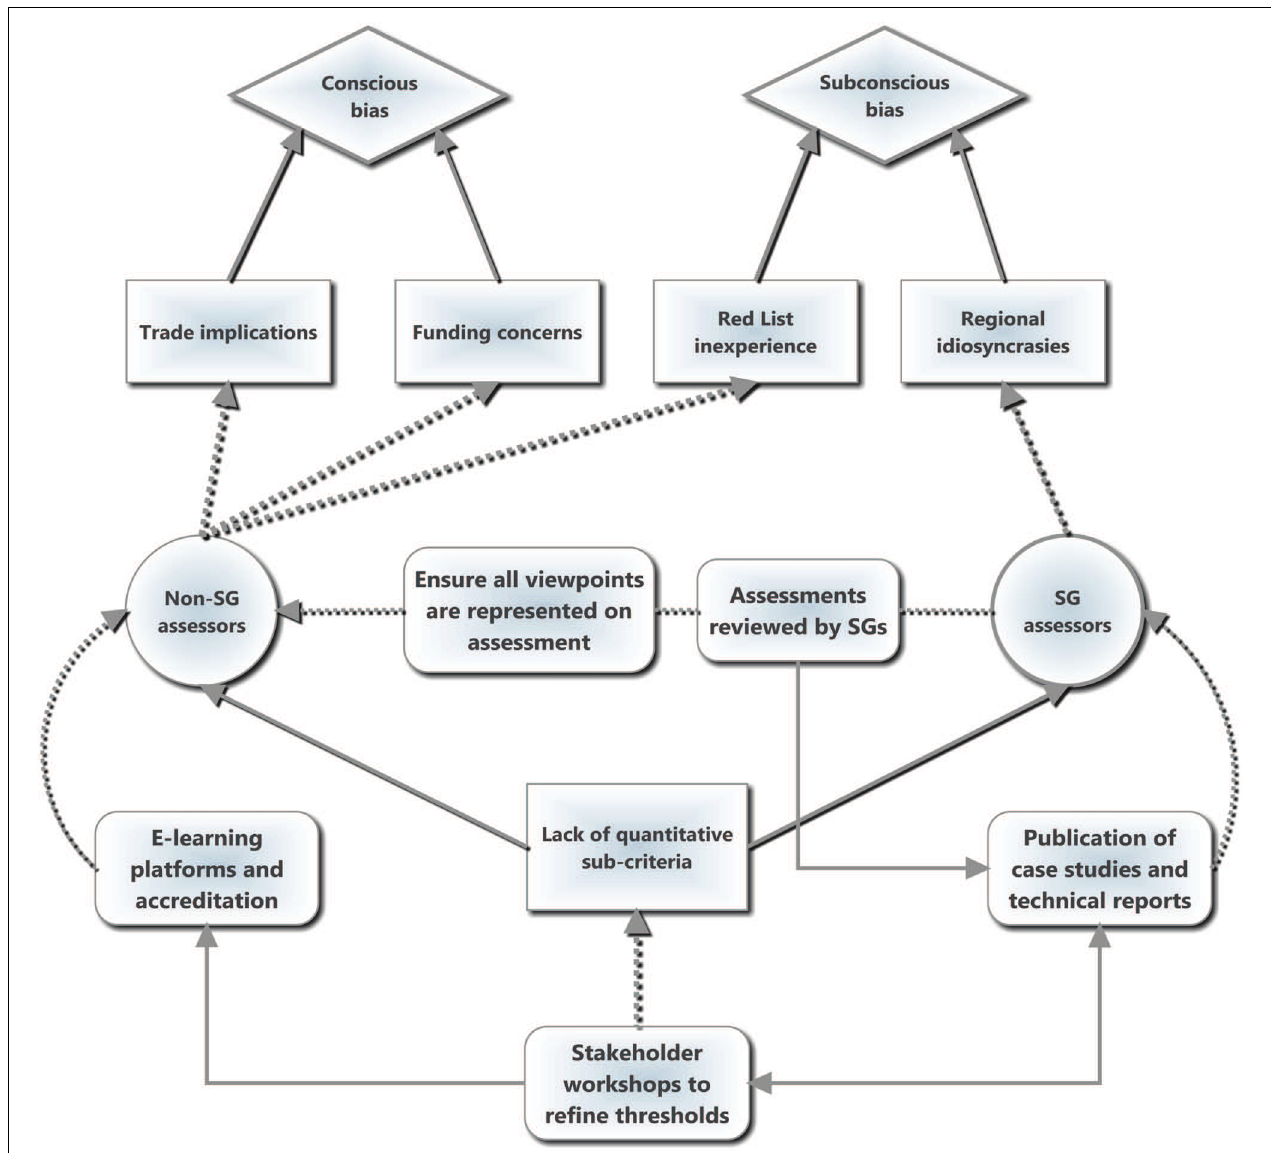
FIGURE 1 | A schematic diagram illustrating both the sources of bias and suggested interventions. Diamond shapes represent bias types, squares indicate drivers, circles represent actors, and rounded rectangles represent suggested interventions by the Species Survival Commission Specialist Groups (SGs) to counteract the causes of bias. Solid lines indicate causal relationships and/or feedbacks while dotted lines indicate actions. We suggest that the lack of quantitative sub-criteria is the root cause of both conscious and subconscious of bias by enabling various mechanisms (examples displayed) to influence Red List assessments. The primary intervention is to use stakeholder workshops to refine the sub-criteria by adding measurable thresholds, which can then